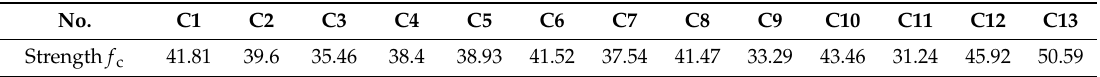
Table 2. Tensile strength f t of prismatic specimens (MPa).